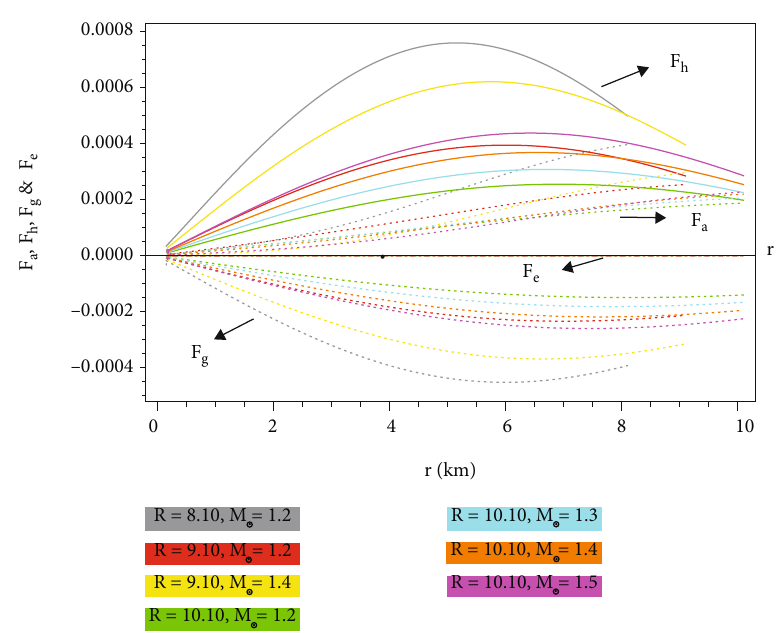
Figure 7: Behavior of F